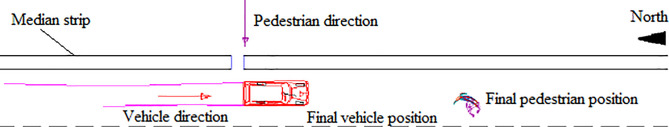
Final position of the vehicle and pedestrian.